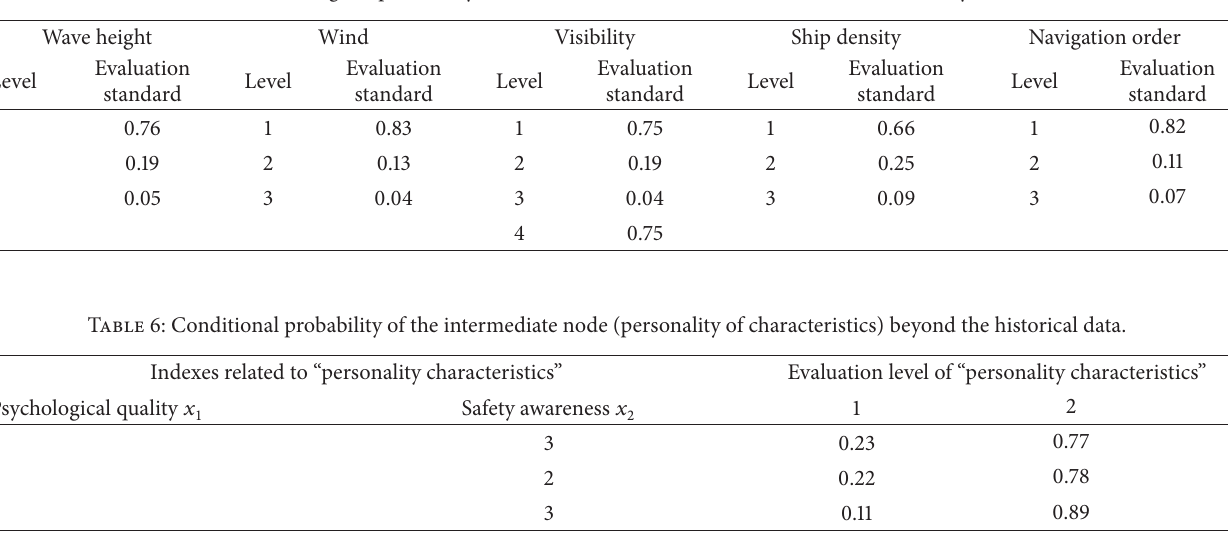
Table 5: Marginal probability of environment’s evidence nodes calculated from fuzzy set.